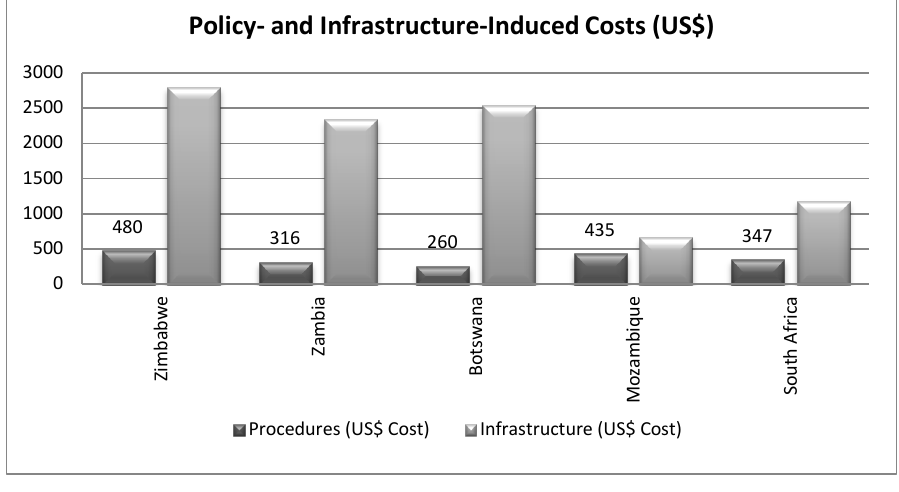
FIGURE 1a: Policy and Infrastructure Induced Costs Source: